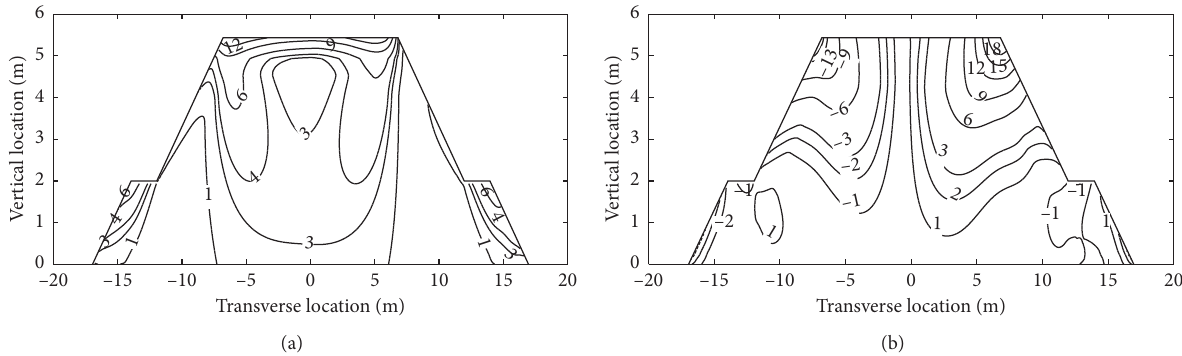
Figure 10: Distribution of roadbed section on March 10, 2014. (a) Vertical displacement field. (b) Horizontal displacement field.